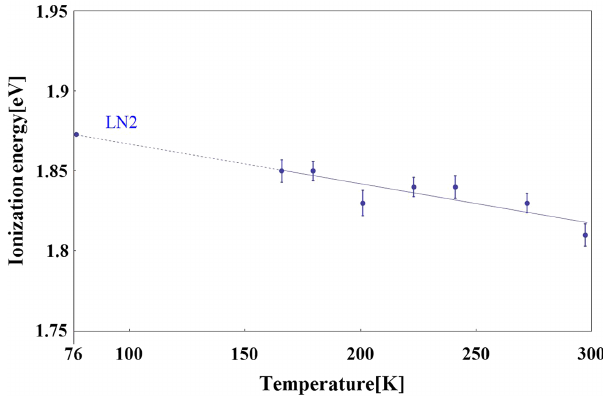
FIG. 4. Ionization energy, E